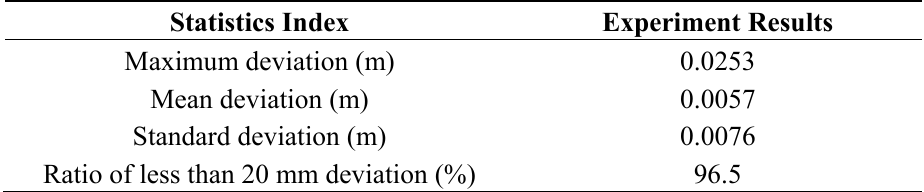
Table 3. Accuracy of the vertical displacements measured with